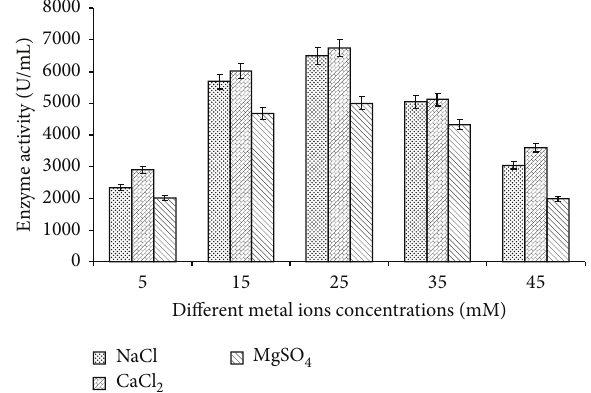
Figure 11: Effect of different concentration of metal ions (NaCl, CaCl 2 , and MgSO 4 ) on amylase production. Test flasks contained different concentrations (5 mM to 45 mM) of metal ions (NaCl, CaCl 2 , and MgSO 4 ) in the medium. The flasks were inoculated with culture and were incubated at initial pH 7.0, 55 ∘ C for 24 h. For enzyme activity, the reaction was assayed by standard assay method. Error bars presented mean values of ± standard deviation of triplicates of three independent